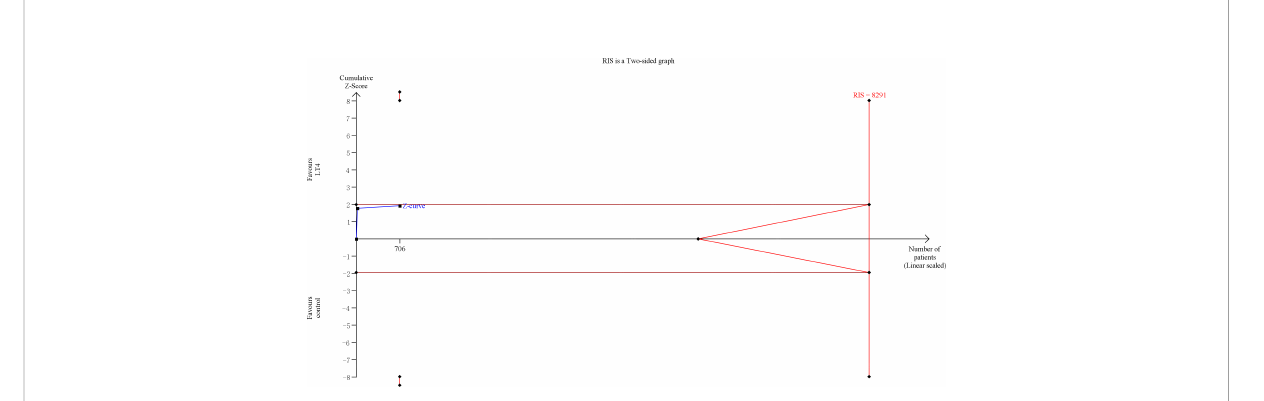
FIGURE 3 Trial sequential analysis of miscarriage. The risk of typeIerror was set at 5% with a power of 80%. The variance was calculated from the data obtained from the included trials. The relative risk reduction (RRR) was set at 20%.